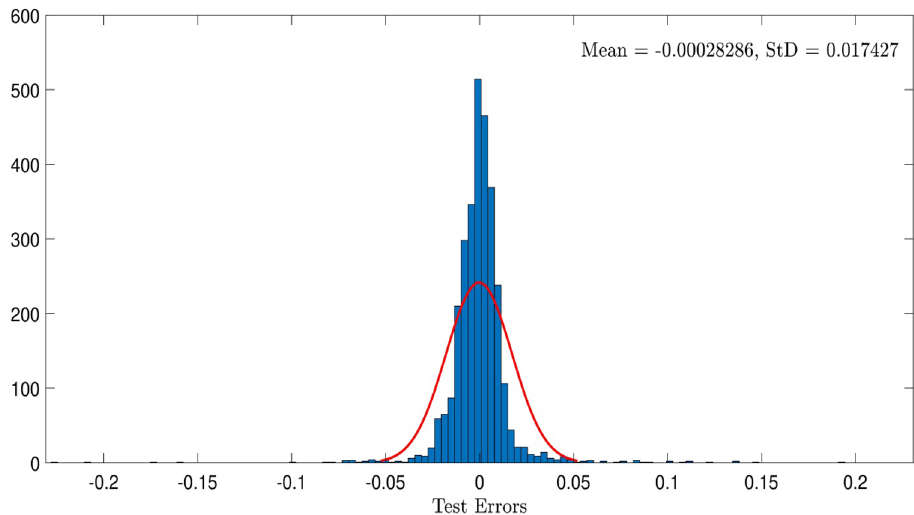
Figure 6. Testing errors histogram in the best of intelligence when CIR is 0.5, number of ants is 20, and the pheromone effect is 0.2.